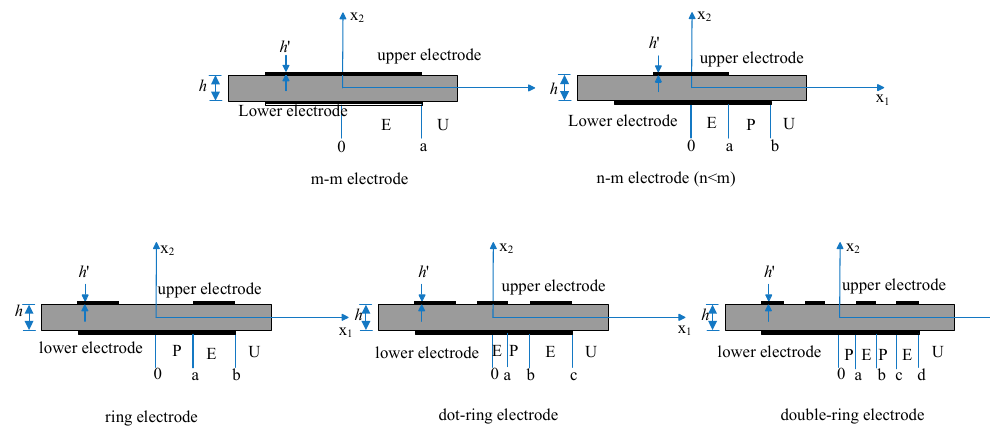
ff erent electrode